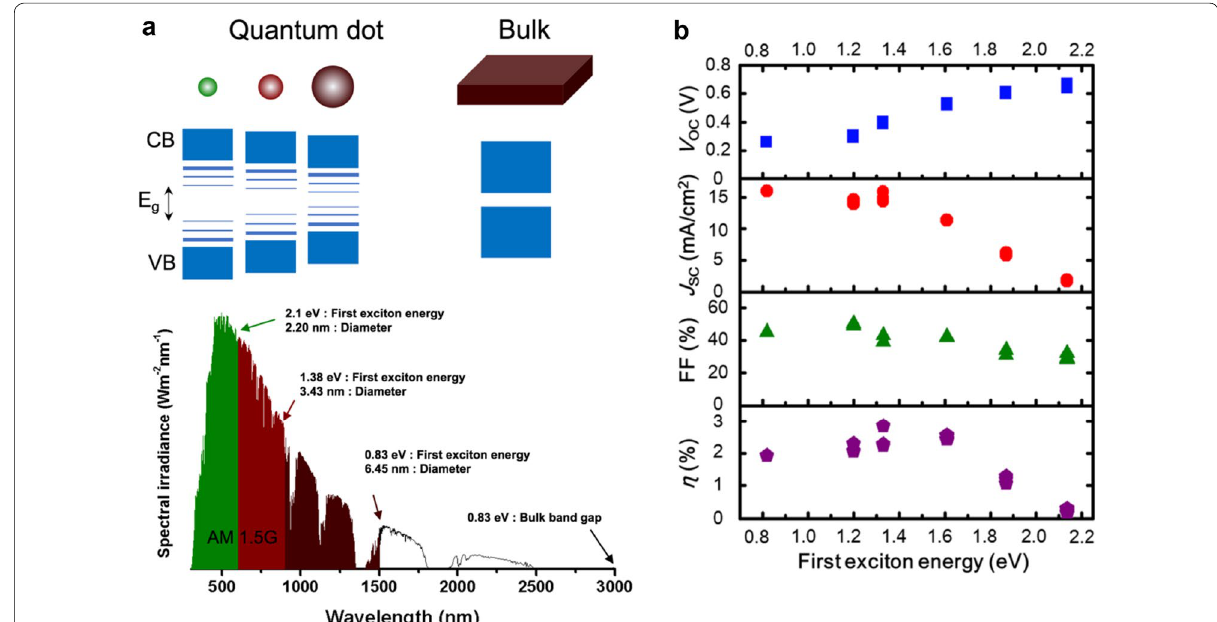
Fig. 1 a AM 1.5G solar spectrum (from ASTM G173-03 reference spectra), band diagram, and first exciton energy of PbS CQDs with various diam- eters. b Characteristics of Schottky junction PbS CQD PVs as a function of the first exciton energy (reprinted with permission from ref. 6,